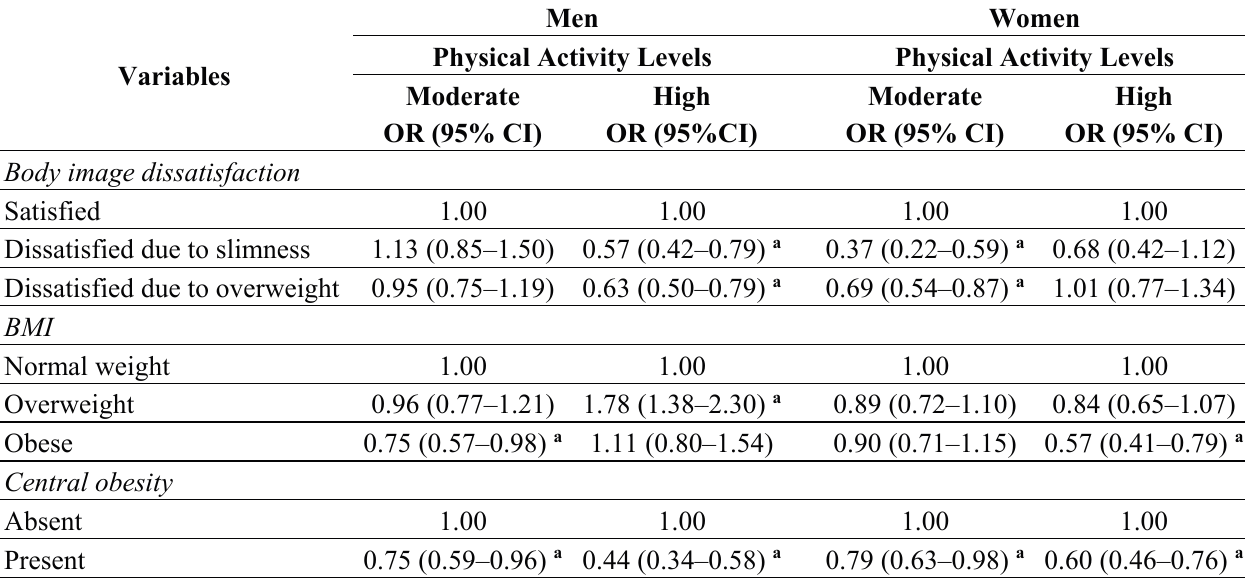
Table 3. Adjusted b Odds Ratios for physical activity, according to body characteristics among adults (35–64 years-old), categorized by sex. ELSA-Brasil